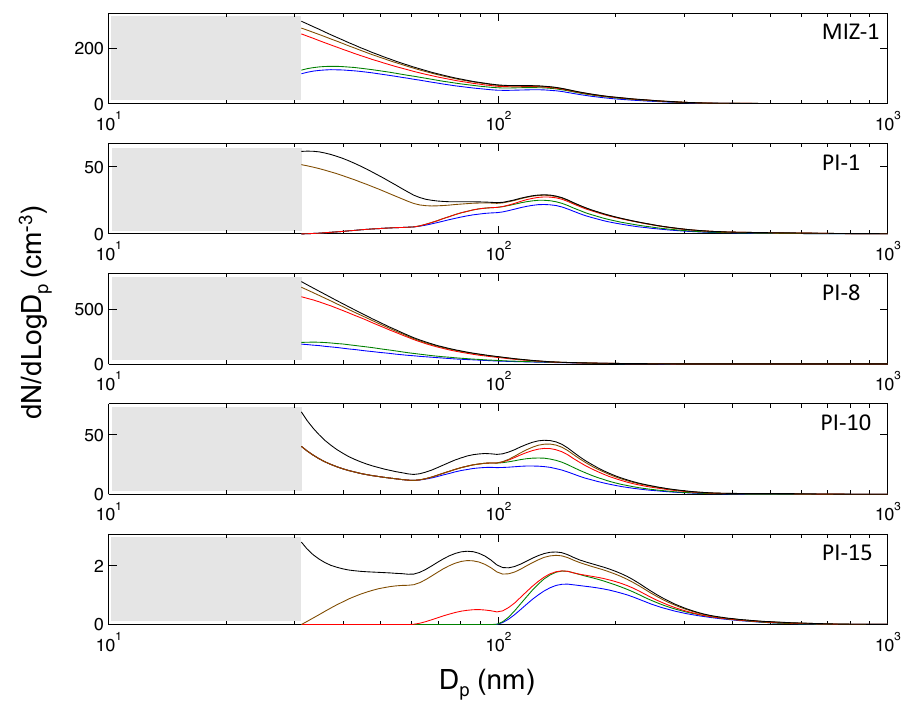
Figure 9. Number concentrations derived from impactor mass data. Blue lines show sulfate only, green lines sulfate + MSA, red lines sulfate + MSA + Na + + Cl − , brown lines sulfate + MSA + Na + + Cl − + Ca 2 + , and black lines show the total analysed